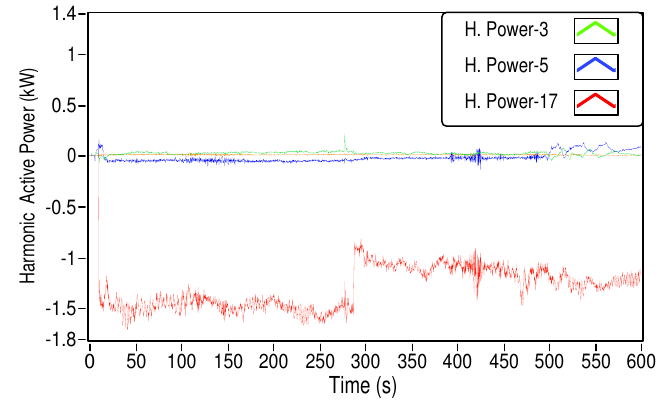
Figure 13. Harmonic power, 3rd, 5th, 11th and 17th, of Journey 1.